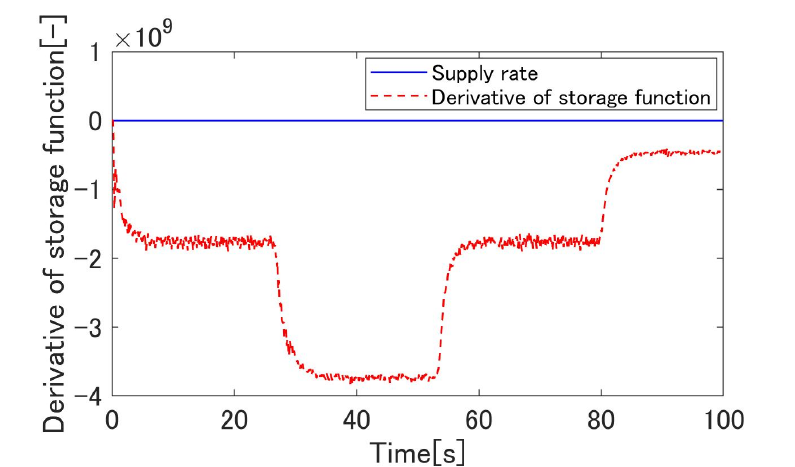
Figure 27. The derivative of the storage function V .